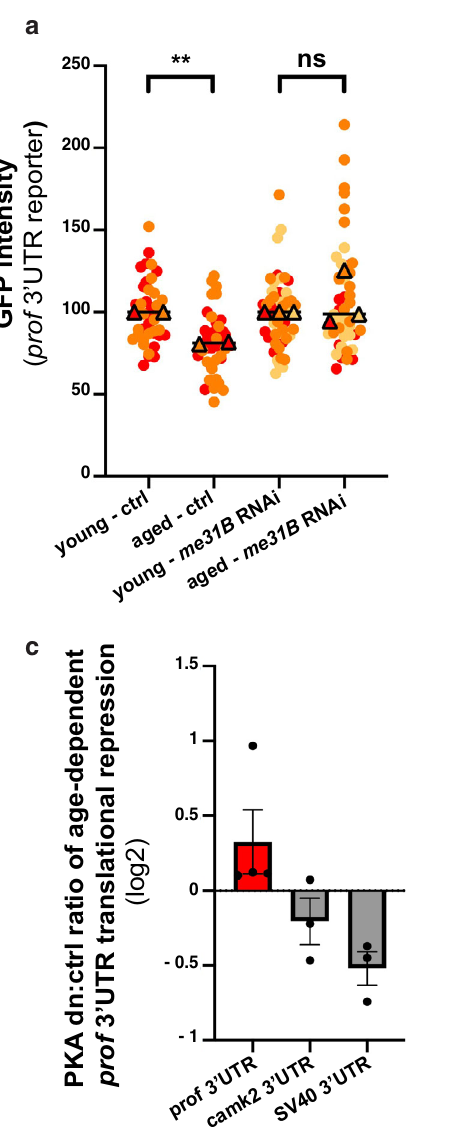
Fig. 8 Me31B and PKA are required for age-dependent translation repression. a GFP signal intensities measured from 1 – 2 day- (young) and 37 – 38 day- (aged) old brains expressing GFP- pro fi lin 3 ’ UTR with (right) or without (left) me31B RNAi. Both the GFP- pro fi lin 3 ’ UTR reporter and the me31B RNAi construct were expressed in MB neurons using the OK107-Gal4. Two replicates were performed for the control condition and three for the RNAi condition.